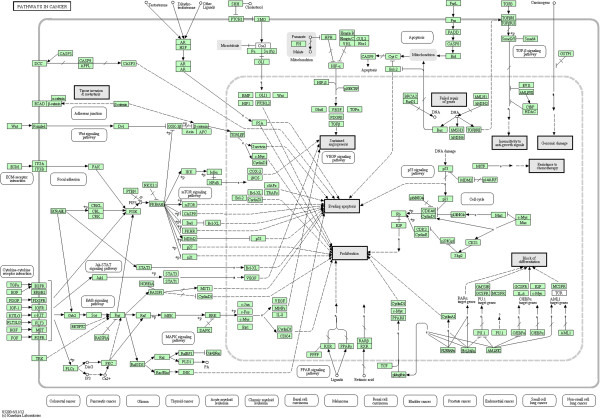
Pathway in cancer, includes PIK3R1.